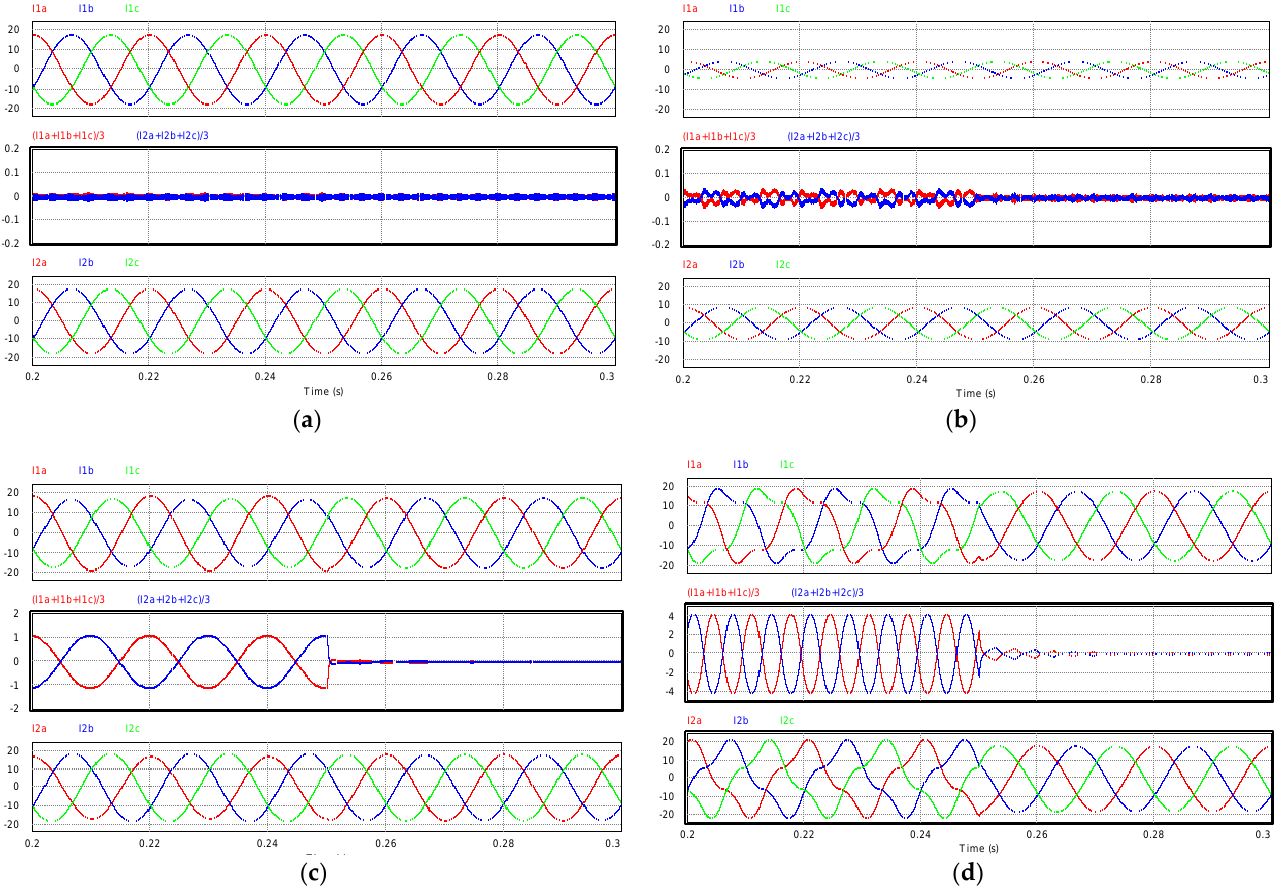
Figure 9. Simulation results of the control of the circulating currents of two inverters connected in parallel ( a ) with unbalanced inductances in both inverters, ( b ) with unbalanced load factor between inverters, ( c ) with unbalanced inductances in the same inverter, ( d ) with a different modulation in each inverter.